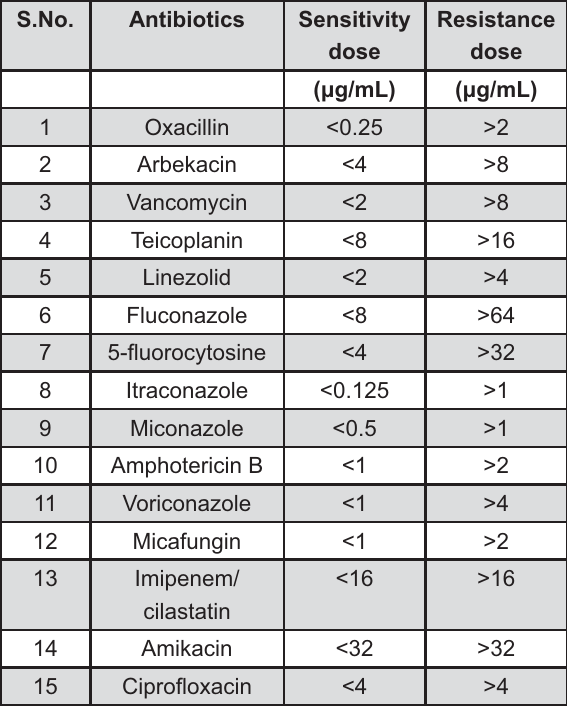
Figure 1- Antibiotics used to test the antimicrobial